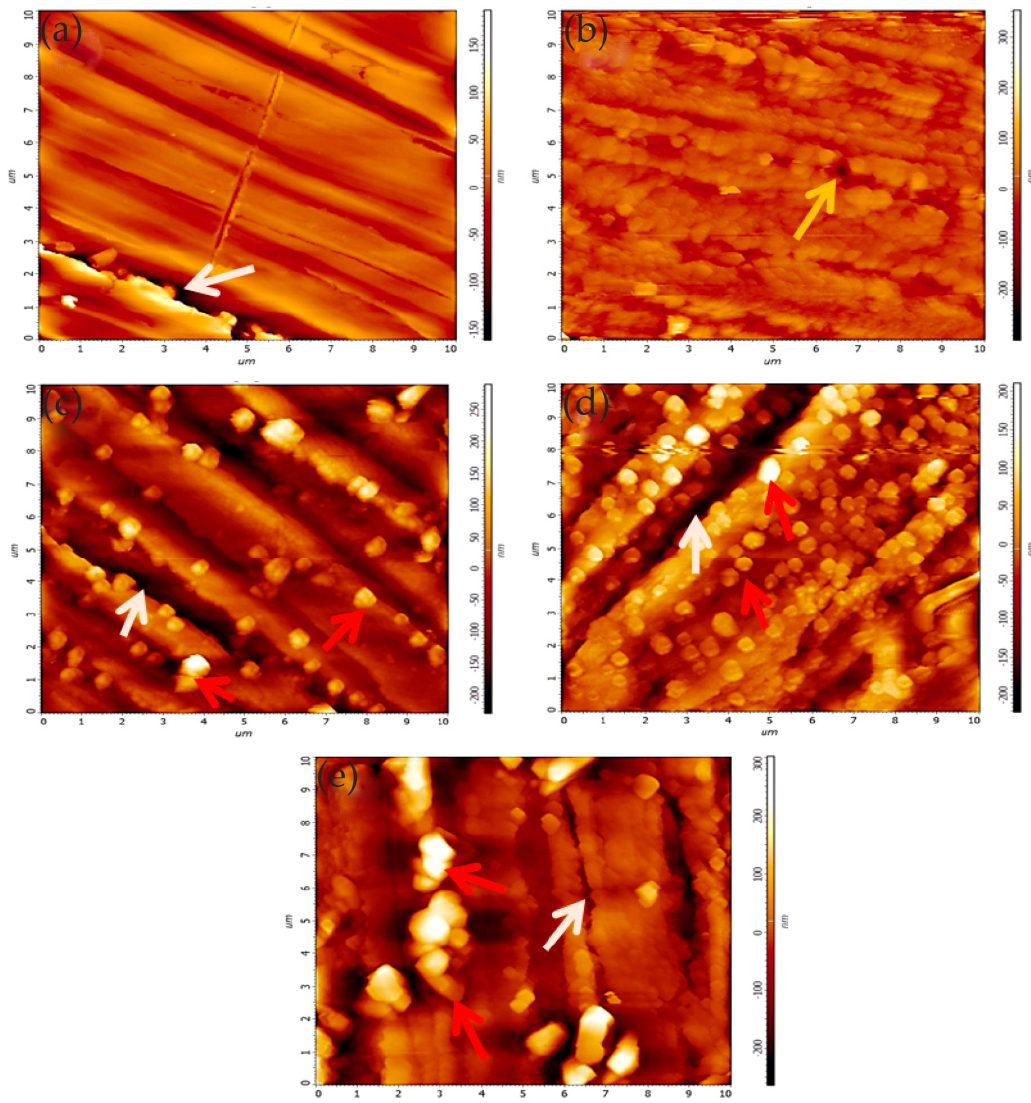
Figure 34. EC-AFM two-dimensional (2D) images of ( a ) polished copper, and copper ( b ) corroded, as well as inhibited by ( c ) ethyl-2-cyano-3-(4-(dimethylamino) phenyl) acrylate (ECDPA), ( d ) EZ3 (ECDPA–ZnO at 300 °C), and ( e ) EZ5 (ECDPA–ZnO at 500 °C) in 10 min of immersion in 1 M HCl at − 0.005 V. Reprinted with permission from Reference [78]; copyright 2019 Elsevier Ltd.